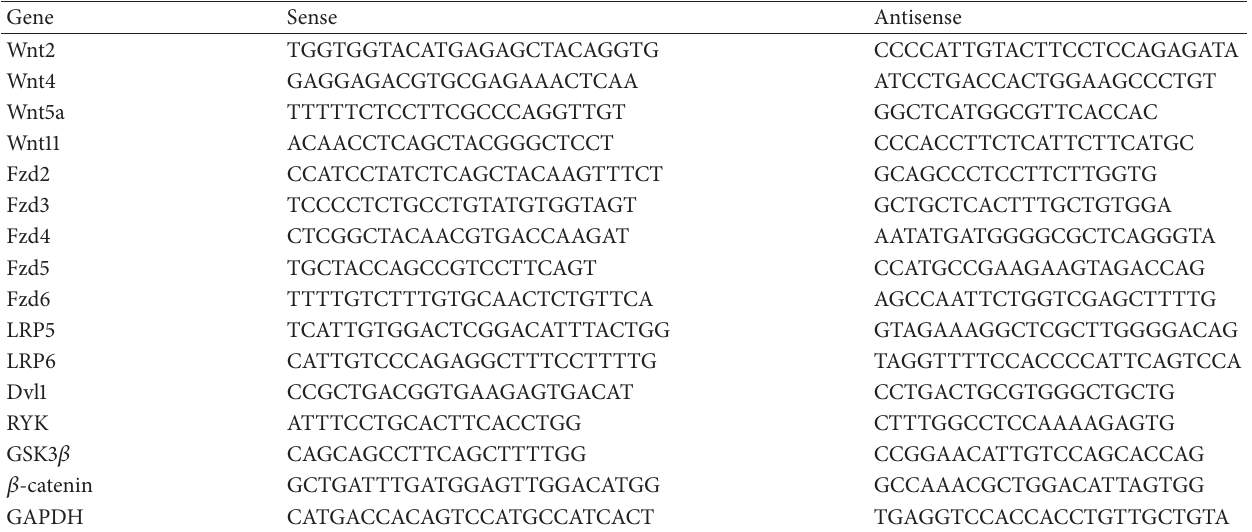
Table 1: Sequence of PCR